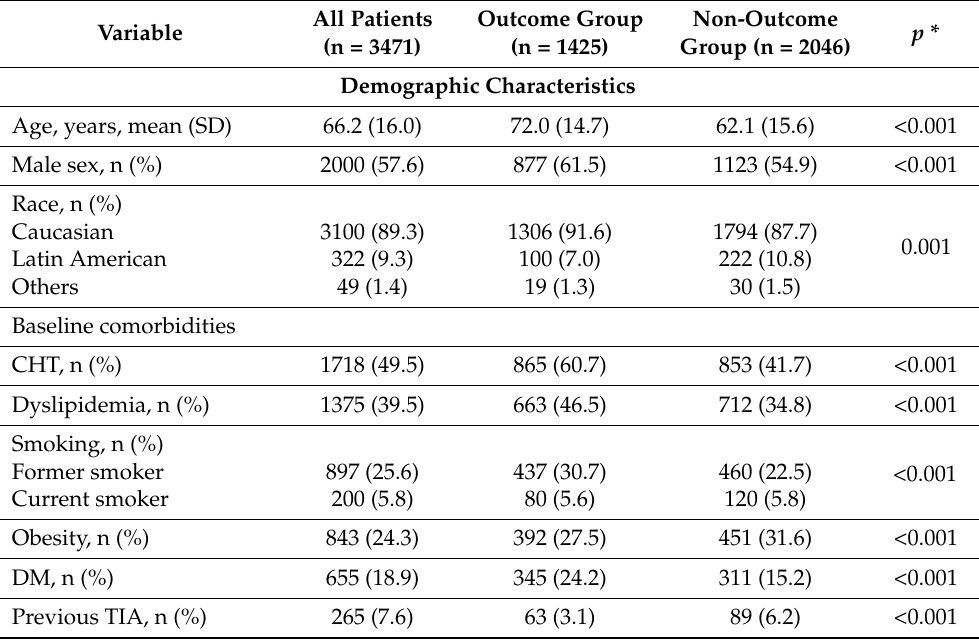
Table 1. Baseline characteristics and pharmacological treatments of study